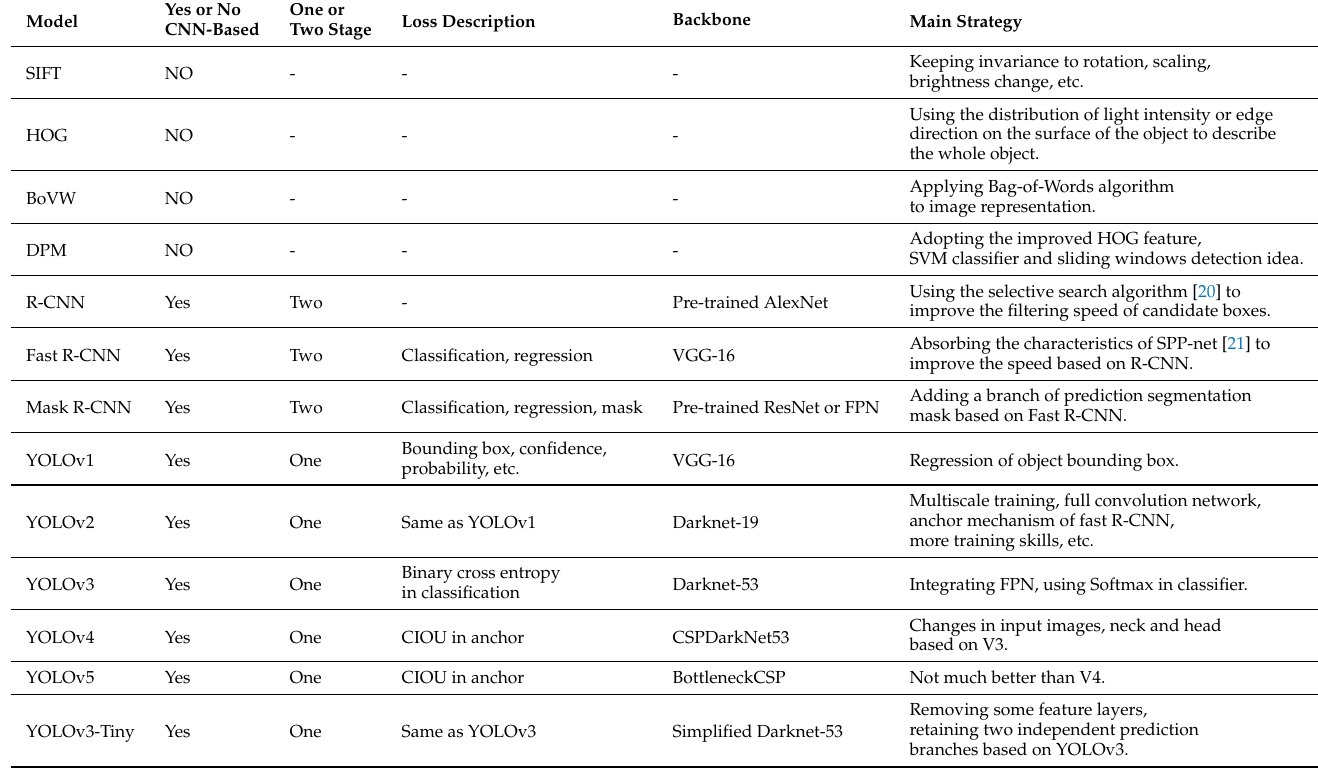
Table 1. Classification of the discussed works along their main distinctive